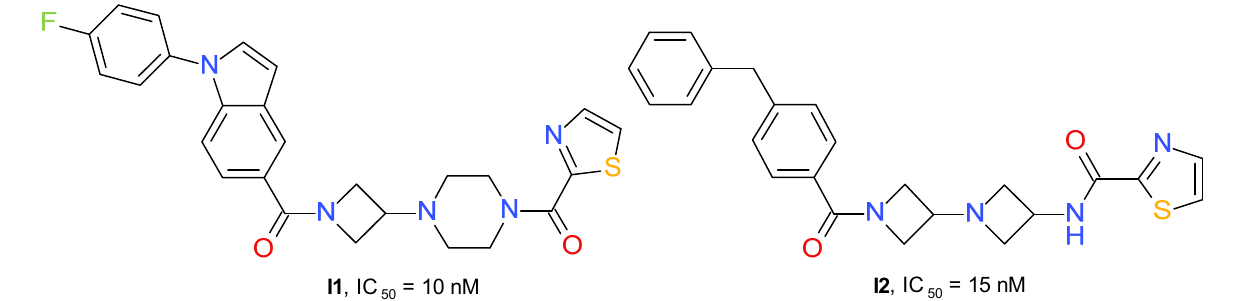
Figure 11. Reversible MAGL inhibitors—azetidinyl amide derivatives.